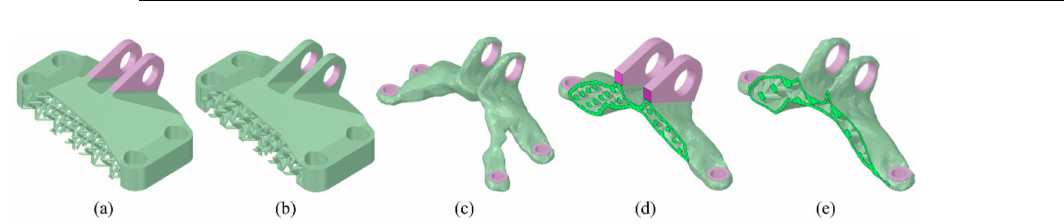
Figure 11. The best design solutions in the different optimization methods: ( a ) Lattice, ( b ) LO, ( c ) TO, ( d ) TO_Lattice, and ( e ) TO_LO.